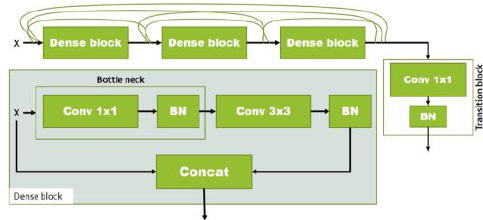
Figure 4: The decoder block of DRU-Net (Jafari et al., 2020) network training. The encoder (Figure 3) and decoder